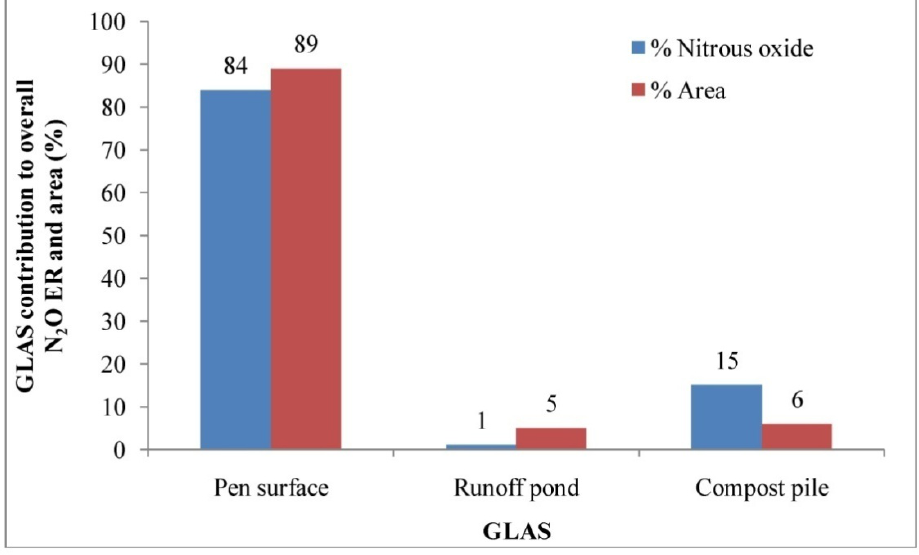
Figure 10. Percent contribution of each GLAS to overall N